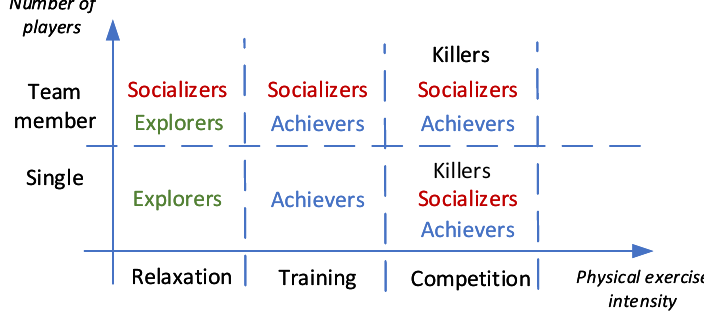
Figure 2. The mode and role in VRrowing